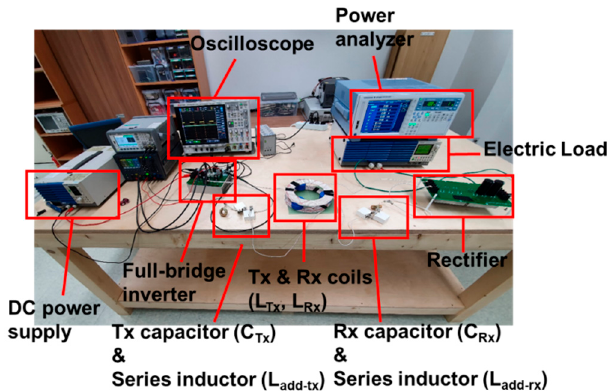
Figure 24. Experimental setup for measuring the transferred power and harmonics of current in a WPT system.